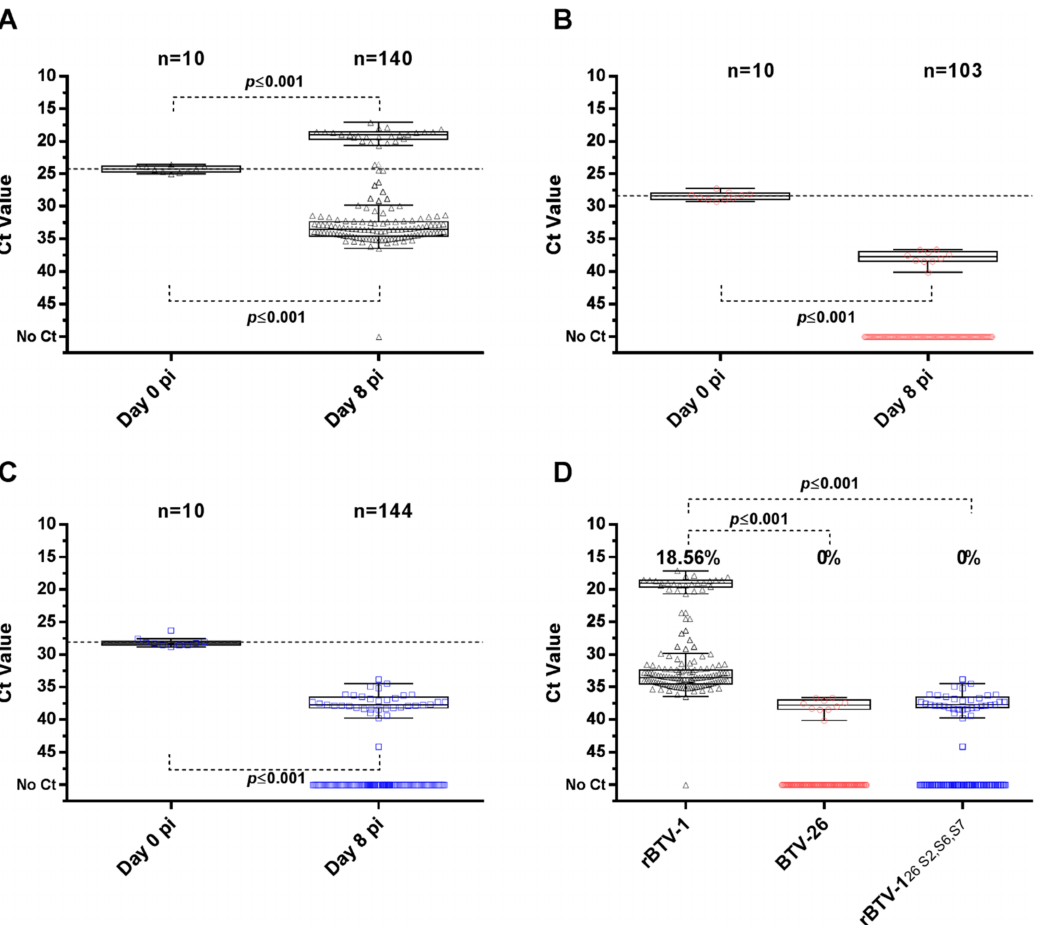
Figure 7. Oral infection of adult Culicoides sonorensis midges with rBTV-1, BTV-26 and rBTV-1 26 S2,S6,S7 . Plotted results for 0 and 8 dpi of adult female C. sonorensis orally infected with 10 7 TCID 50 /mL of ( A ) rBTV-1; ( B ) BTV-26; and ( C ) rBTV-1 26 S2,S6,S7 . In ( A – C ) dotted lines show the threshold that indicates viral levels of transmissibility/vector competence. Box-and-whiskers show median (line), 1st and 3rd quartiles (25th and 75th percentiles) of the different determined populations (Whiskers were defined by the Tukey method, and comparison of medians by Mann-Whitney test). Comparison of all groups at 8 dpi is shown in ( D ), where calculated competence rates are shown as percentages (2 proportions comparison-Minitab). In all panels each symbol represents one individual